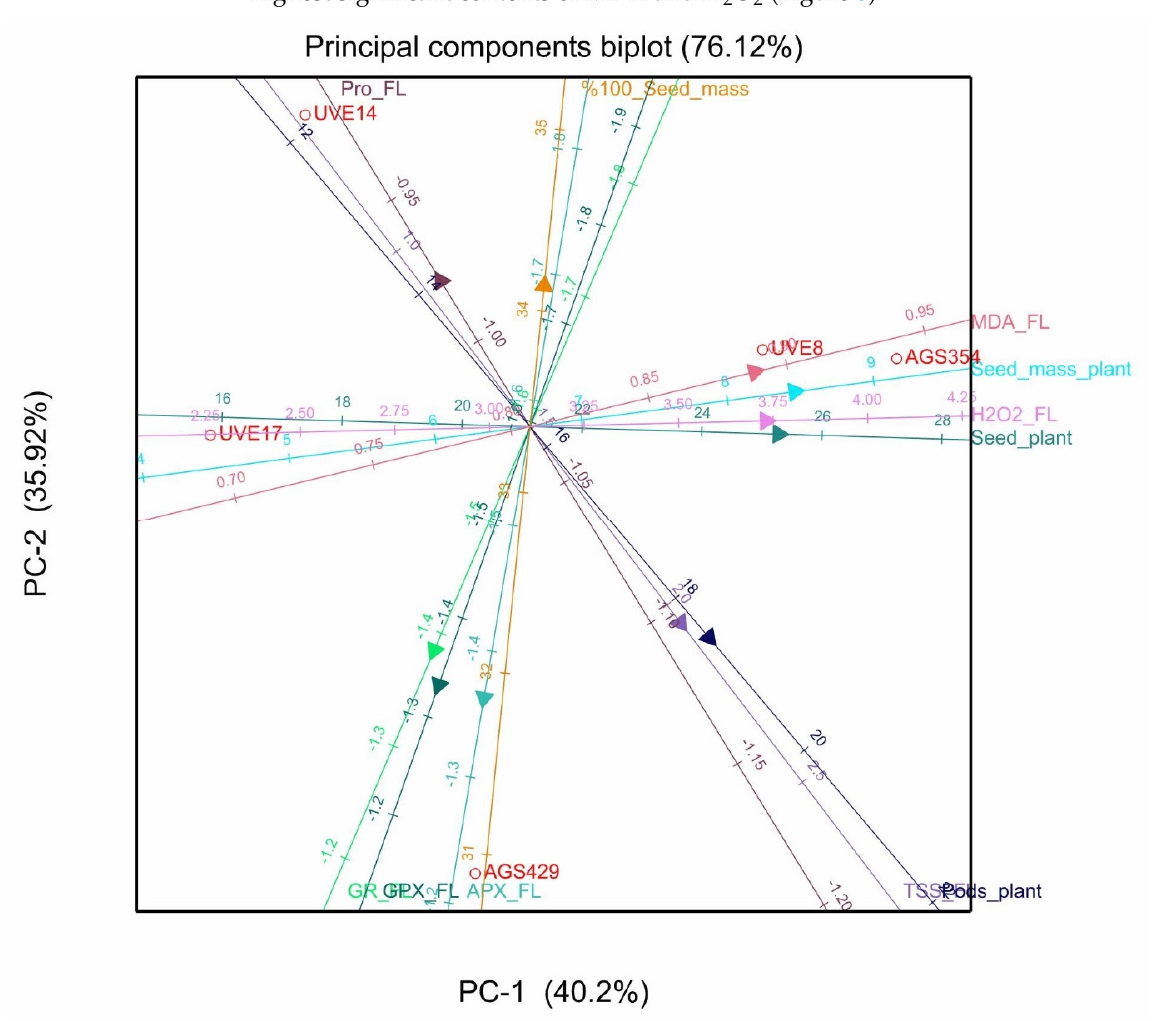
Figure 8. Principal components biplot between PC1 and PC2 showing the contribution of biochemical and yield parameters to the variability of five vegetable-type soybean cultivars subjected to severe stress at flowering. At pod filling, cultivar UVE8 showed the highest production of proline, TSS, and H 2 O 2 , while it showed lower production of APX and GPX. Cultivar AGS429 had the high- est production of GPX and GR, with the lowest production of MDA content (Figure 9).